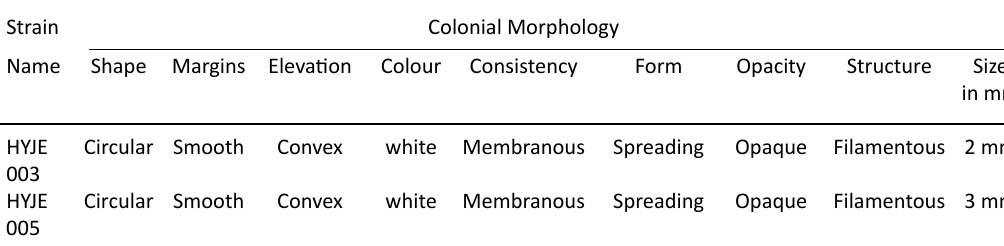
Table 1. Colony morphology of isolated strains Strain